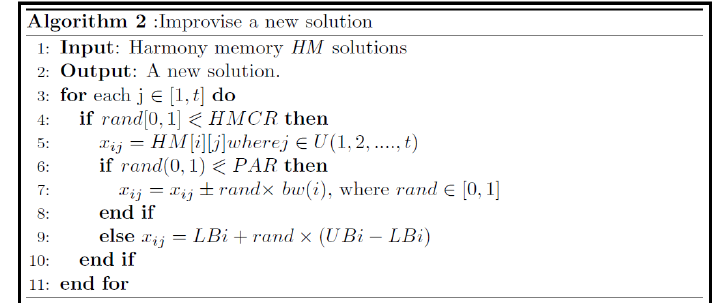
Figure 5. Improvisation of a new solution. Here, UBi and LBi are upper and lower bounds, and bw denotes